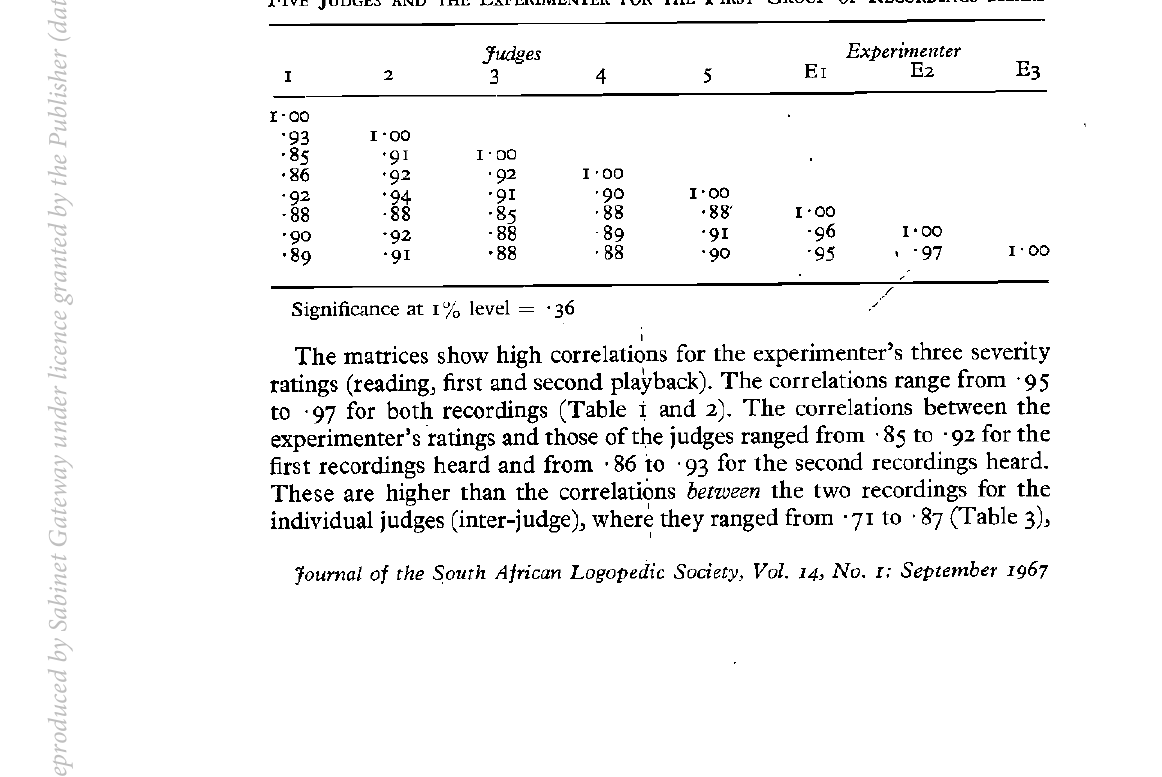
TABLE I: INTER-CORRELATIONS OF THE SEVERITY RATINGS OF STUTTERING MADE BY FIVE JUDGES AND THE EXPERIMENTER FOR THE FIRST GROUP OF RECORDINGS HEARD Judges I 2